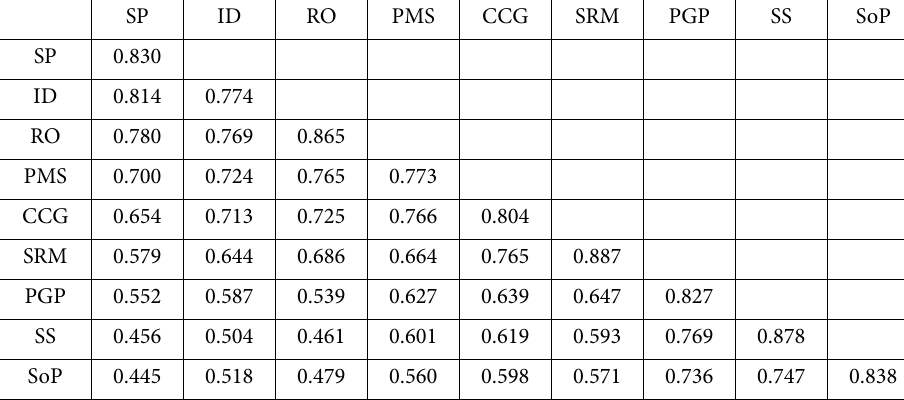
Table 8. Correlation matrix and square root of average variance extracted of latent